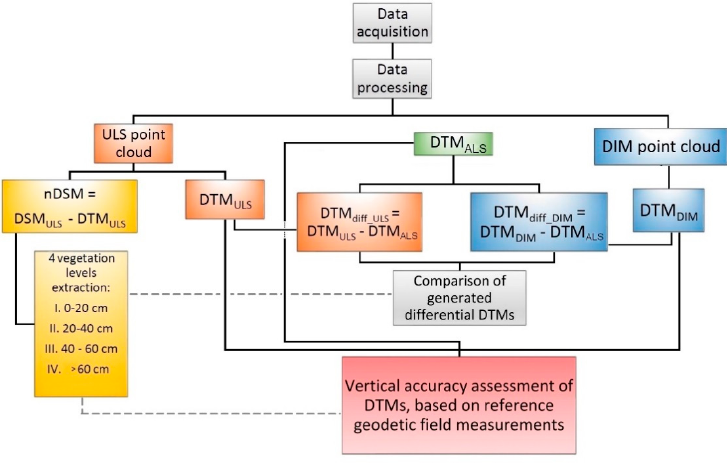
Figure 6. Accuracy assessment methodology.